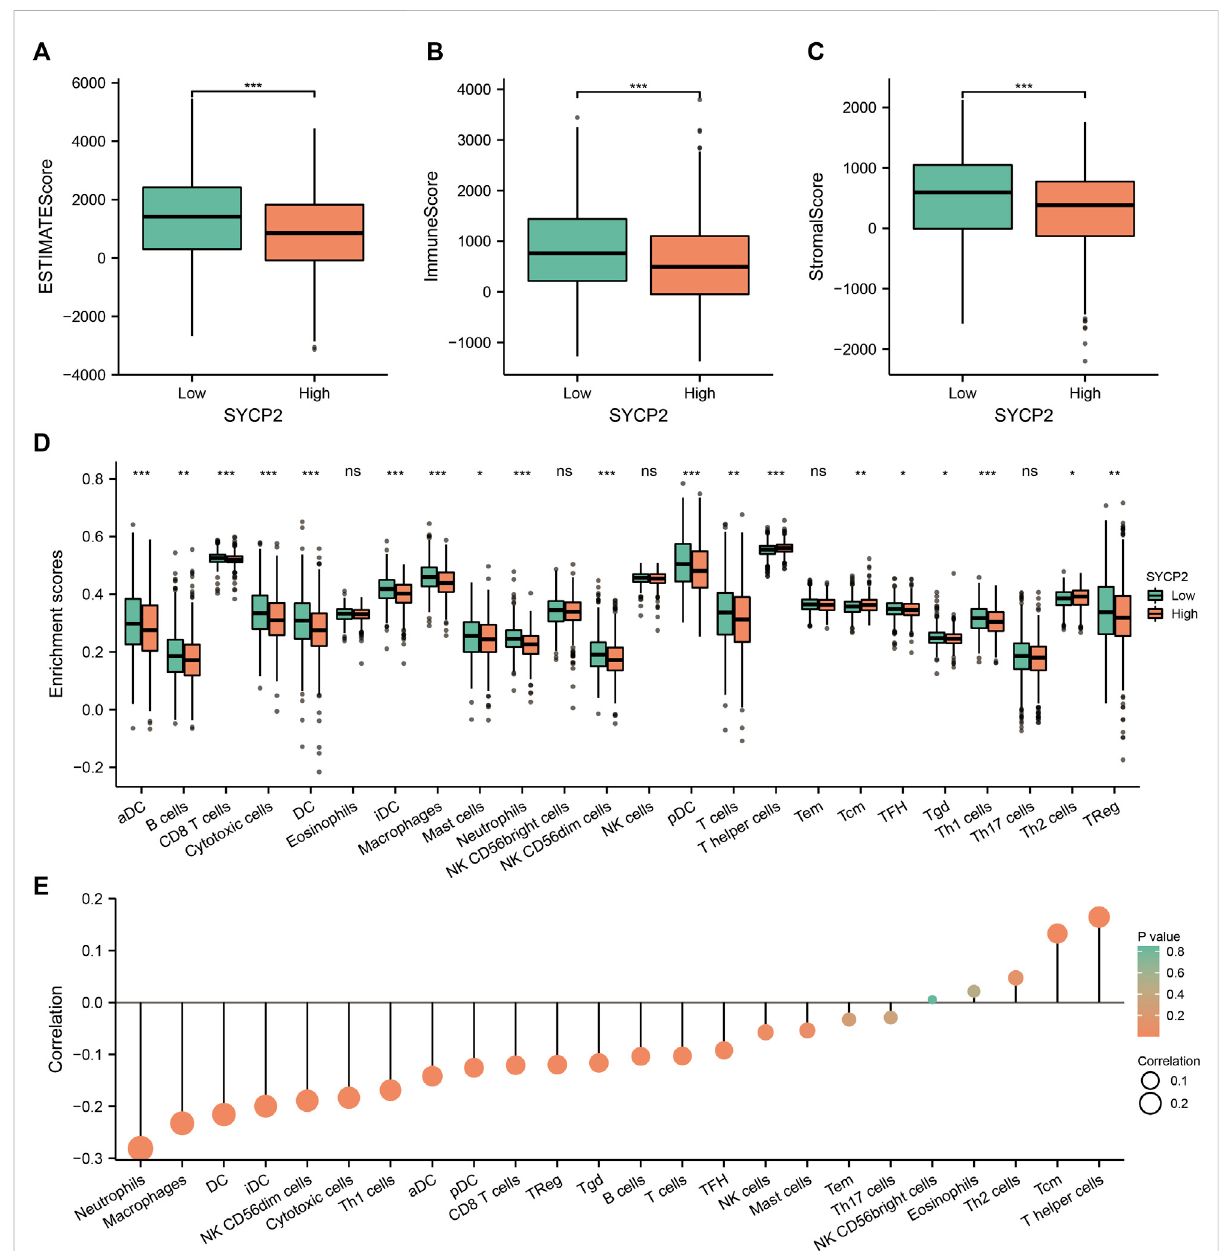
FIGURE 8 Effects of SYCP2 gene expression on immunological characteristics of TCGA-BRCA patients. (A – C) Compared with patients with low expression of SYCP2 , patients with high expression of SYCP2 had a signi fi cantly lower ESTIMATE score ( p < 0.001; Figure 8A), immune score ( p < 0.001; Figure 8B), and stromal score ( p < 0.001; Figure 8C). (D) The abundance of immune cells in high and low expression samples of SYCP2 was assessed based on ssGSEA. (E) Lollipop diagram of SYCP2 expression and immune cell in fi ltration (ns, p ≥ 0.05; *, p < 0.05; **, p < 0.01; ***, p <